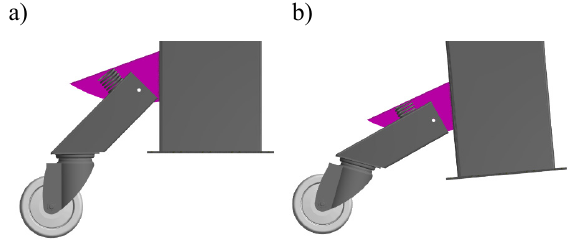
Figure 2. Swivel wheel support movement of solution A: initial spring position (without bed load) (a) and final spring position (with bed load)